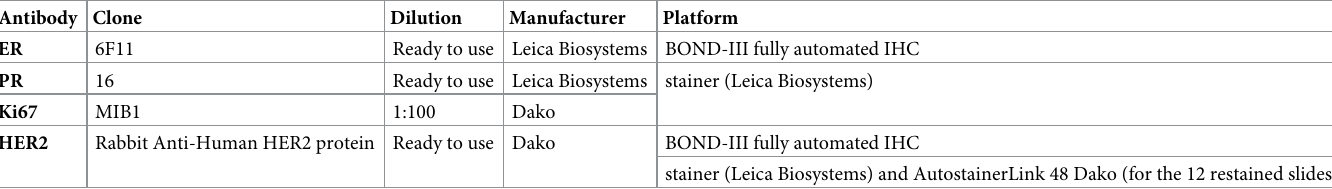
Table 1. Immunhistochemistry staining